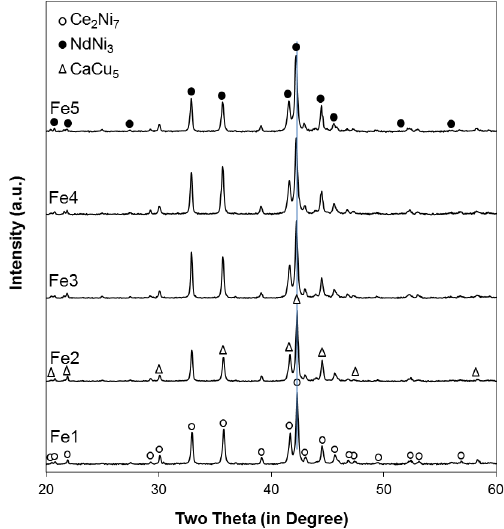
Figure 1. X-ray diffraction (XRD) patterns using a Cu–K α radiation source for alloys Fe1–Fe5. The vertical line shows the shift in the main peak to lower angles (the unit cell becomes larger) with increasing Fe content.